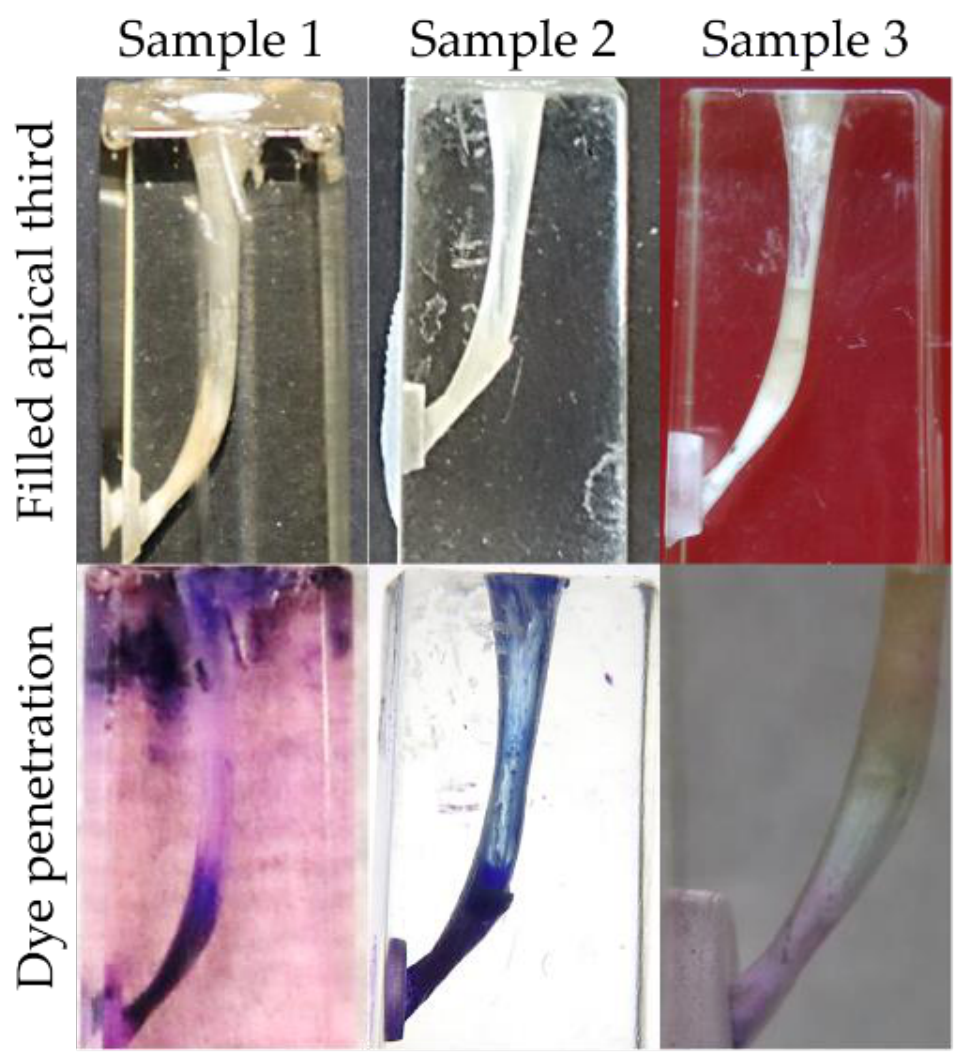
Figure 15. Results of dye penetration tests in endo training blocks following BDD-mediated root canal obturation. As expected, complete penetration was visible in all instances.